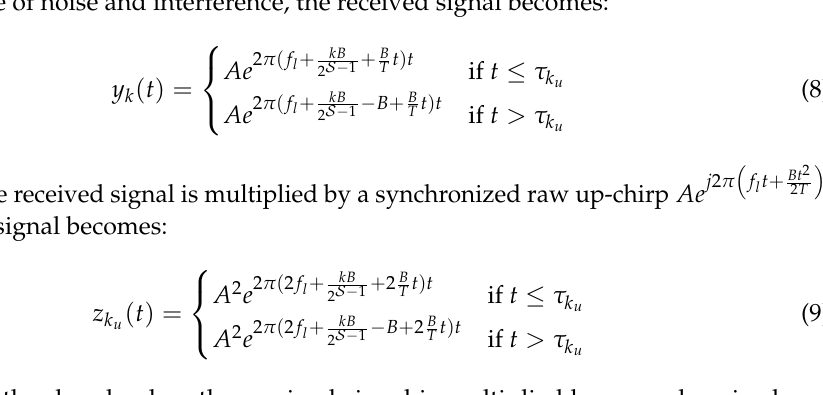
Figure 2. Time-frequency representation of the proposed LoRa modulation for ( b ) k = 1, ( c ) k = 2, ( d ) k =